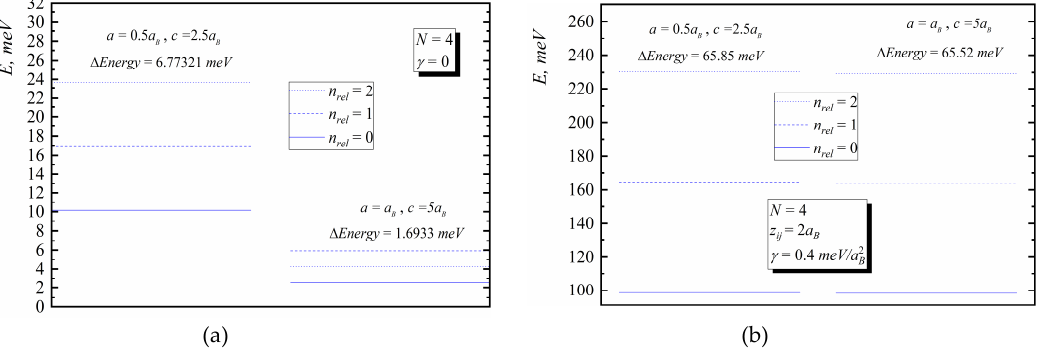
Figure 4. Energy diagram (( a )—without interaction, ( b )—with interaction) for relative motion for four-particle case for the following values: I. a = 0.5 a B , c = 2.5 a B , II. a = a B , c = 5 a B